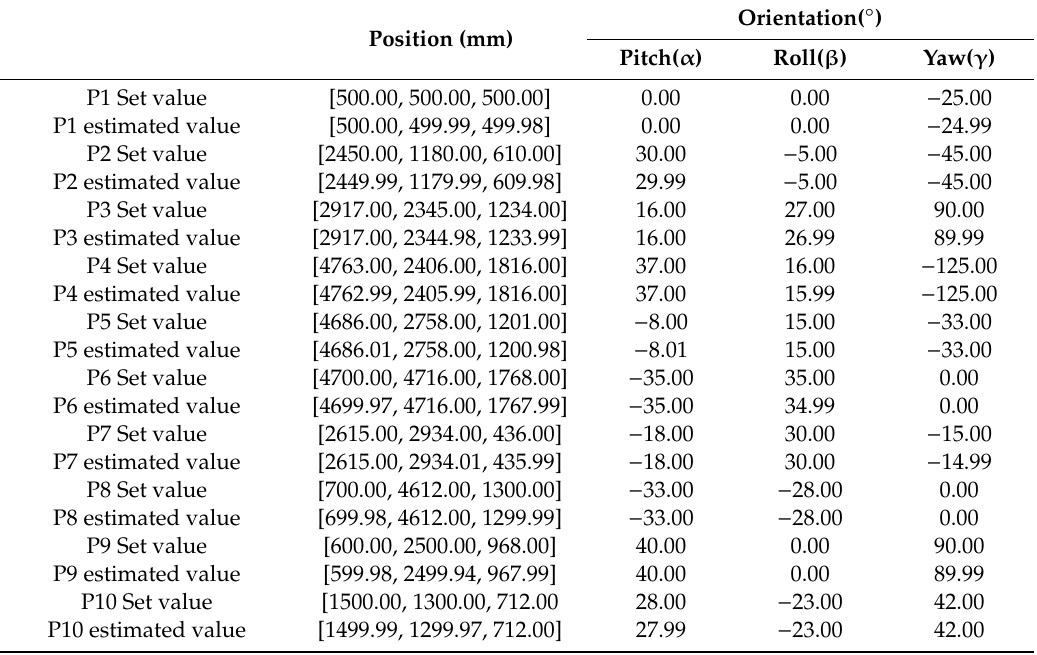
Table 6. The position and orientation of POS.